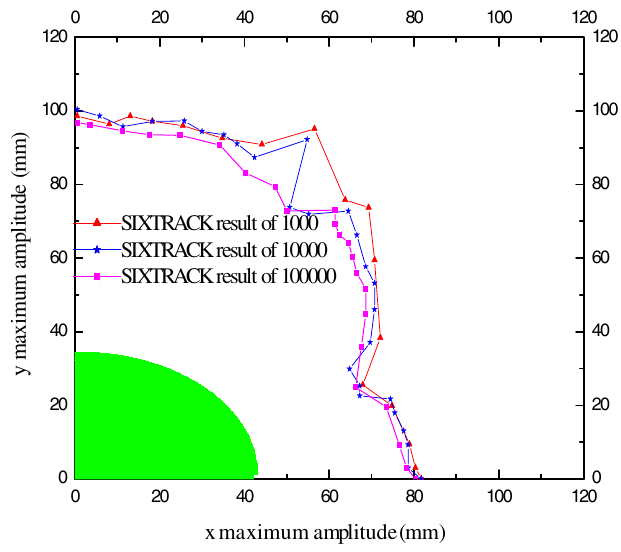
FIG. 4. (Color) Dynamic aperture calculation with SIXTRACK for particles with a momentum deviation of 1.5%. The dynamic aperture, which was tracked over different numbers of turns (1000, 10 000, 100 000), is much larger than the acceptance of the ring (shaded green area).